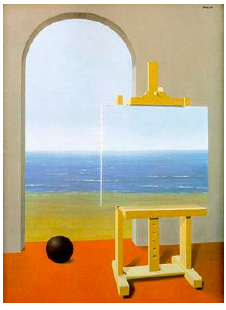
Figure 17. R. Magritte, La condition humaine ,